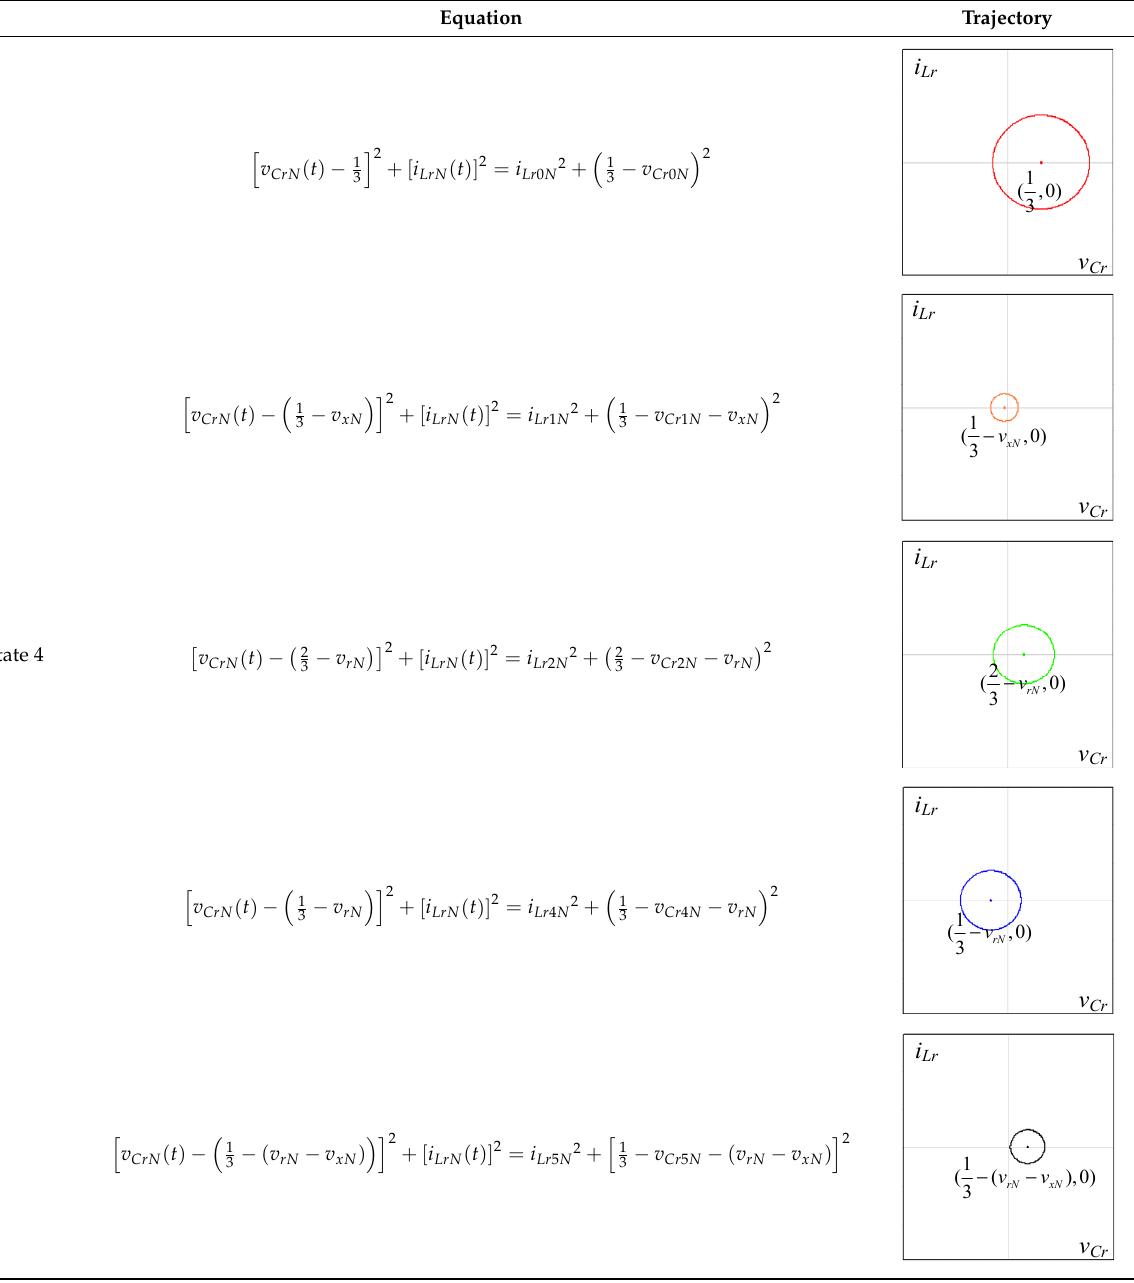
Table 4. Specification of three-phase wye–delta LLC.